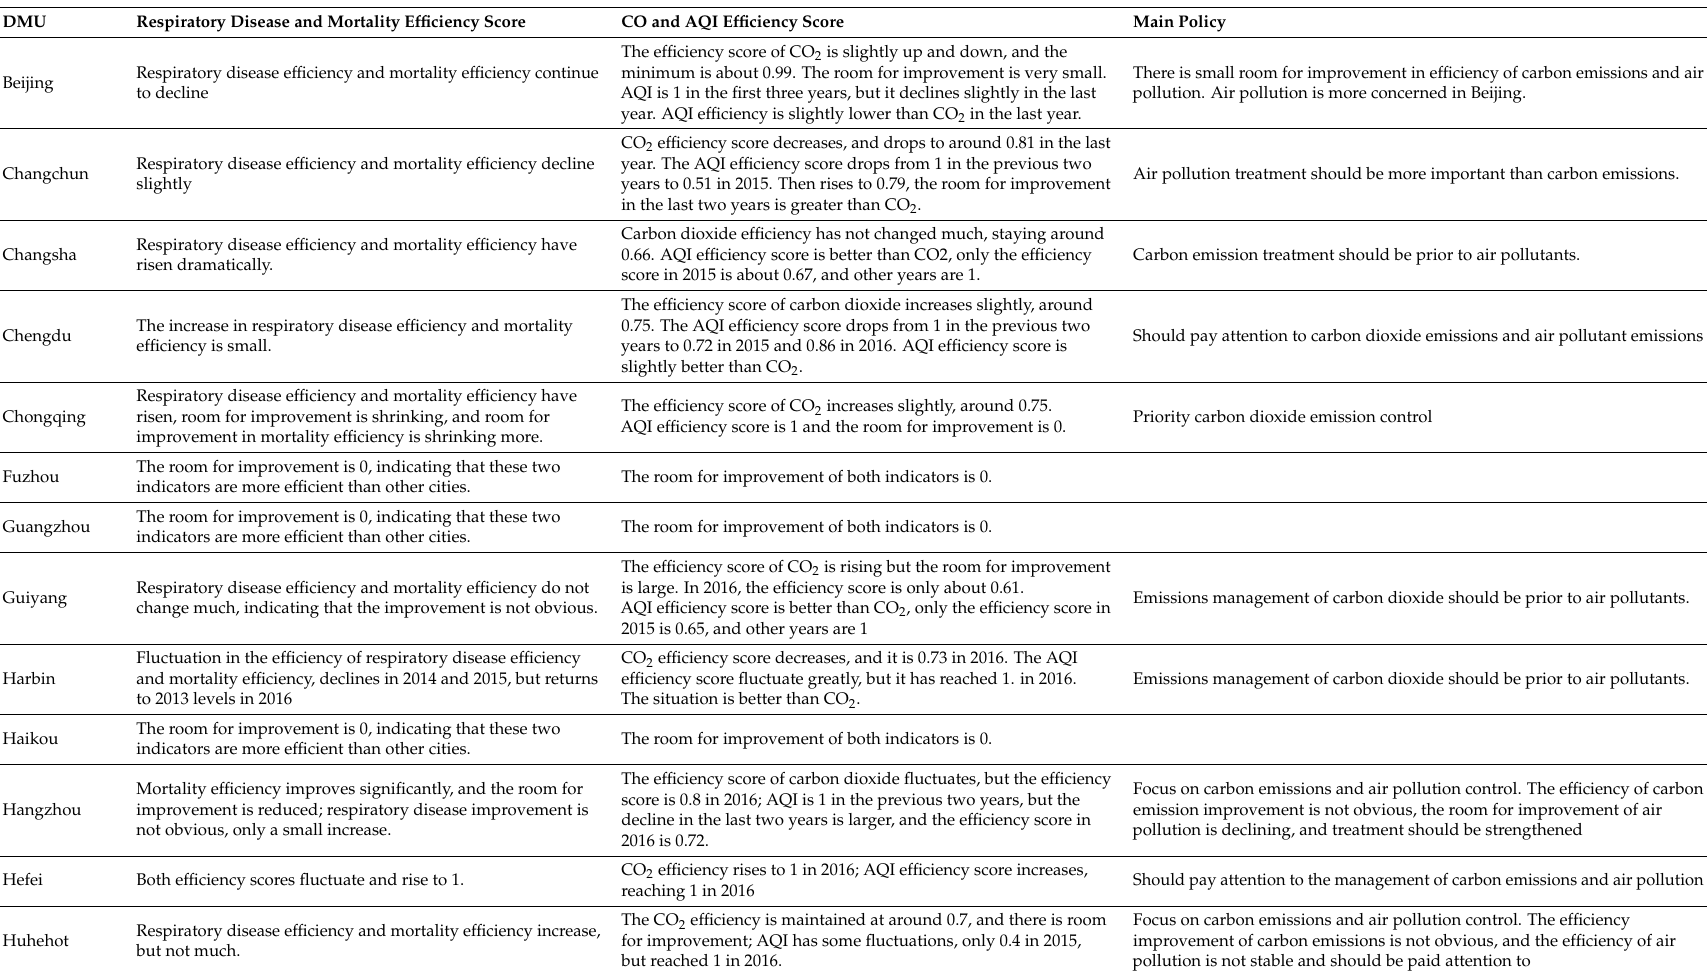
Table 8. Comparison of undesirable output efficiency and policy priorities of each